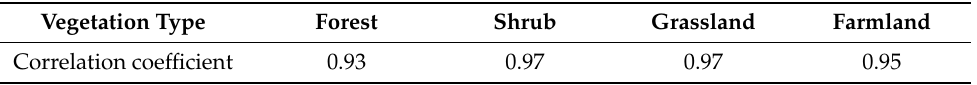
Figure 8. Spatial distribution of the Pearson correlation coefficient ( a ) and the p-value ( b ) between WVCI and VCI for the entire growing season from 2001 to 2019. Table 2. Mean correlation coefficients between WVCI and VCI for various vegetation types through- out the growth season between 2001 and